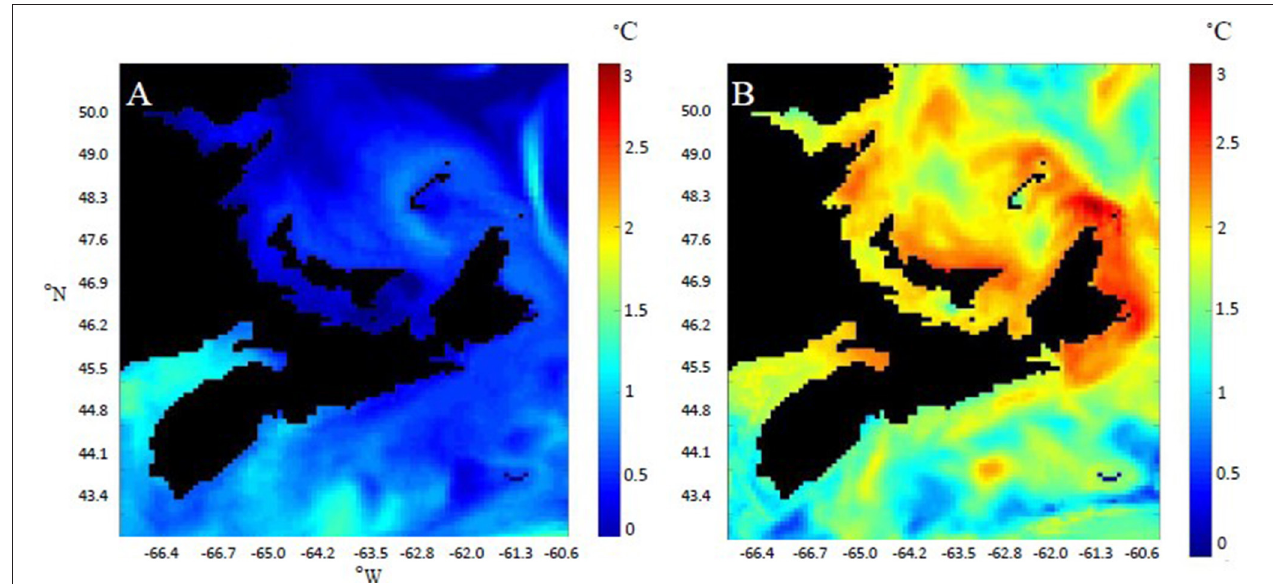
FIGURE 1 | Difference in average temperature ( ◦ C) between the past (1986–1990) and the future (2046–2050) for the Gulf of Saint Lawrence and Scotian Shelf areas within the model domain. Temperatures were calculated by averaging the SST values for the month of January (A) and August (B) , the coldest and warmest months,